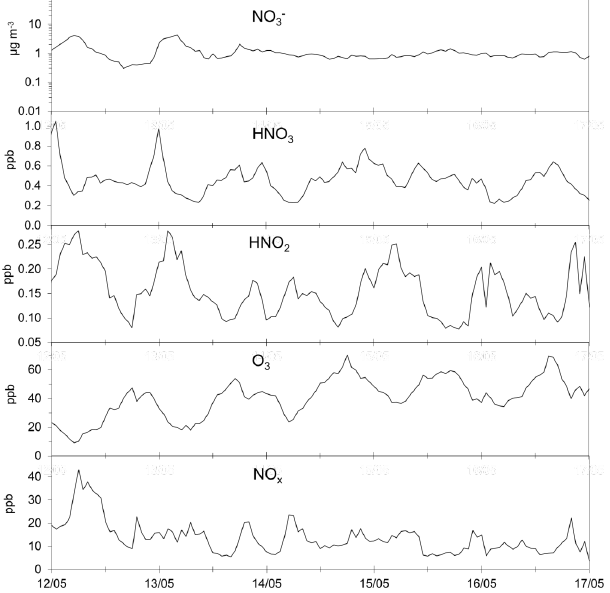
Fig. 8. Ozone, NO x , and the nitrogen-containing gas-phase acids and nitrate in PM 10 in late spring.